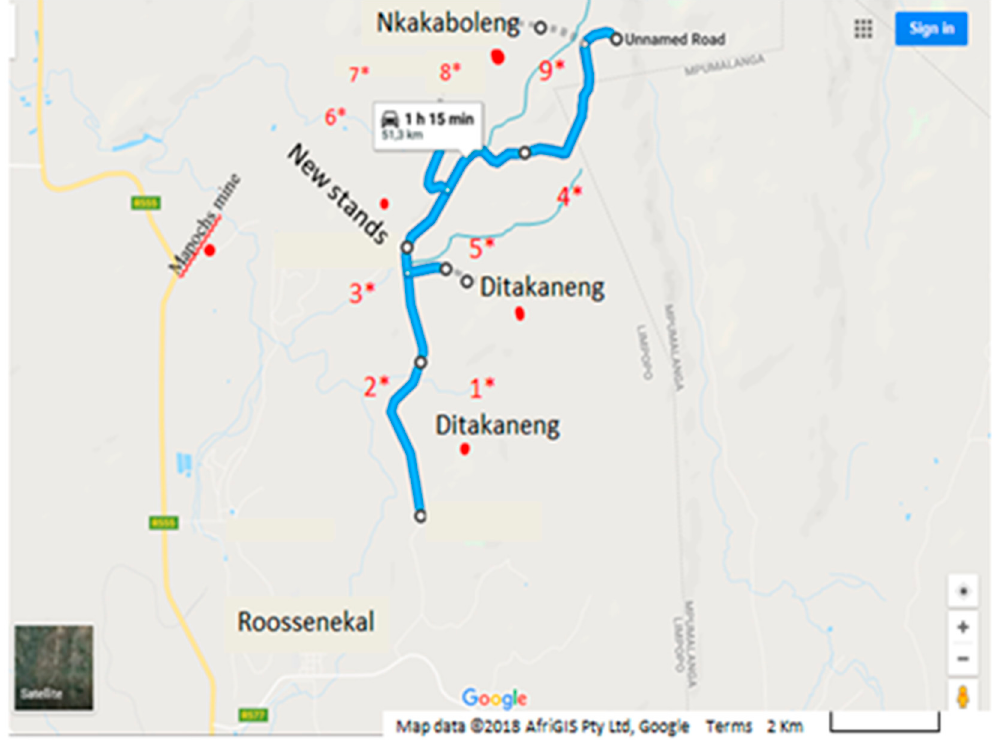
Figure 3. Map of Makwane Village showing all the sections and the surrounding streams/rivers where some of the samples were collected in addition to water collected from households. Source: [17].